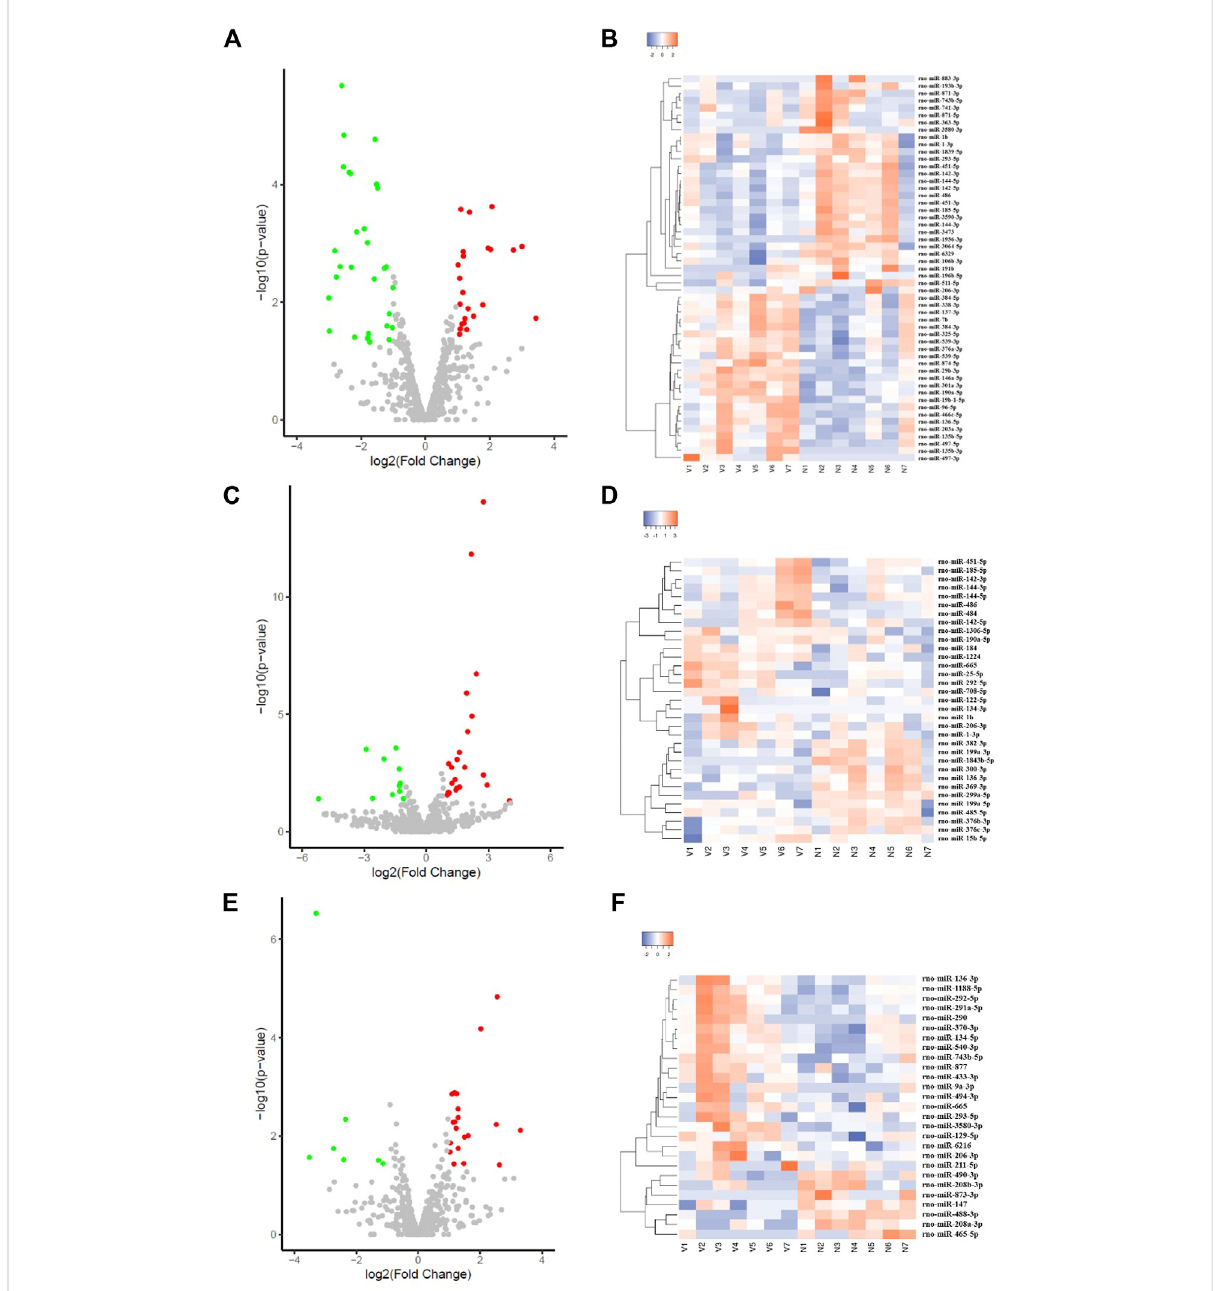
FIGURE 2 VolcanoplotandclusterheatmapofDE-microRNAsintheVSDgroup (A,C,E) areallvolcanoplots; (B,D,F) areclusterheatmaps; (A,B) represents myocardium-derived DE-microRNAs; (C,D) represents amniotic fl uid-derived DE-microRNAs; (E,F) represents maternal serum-derived DE-